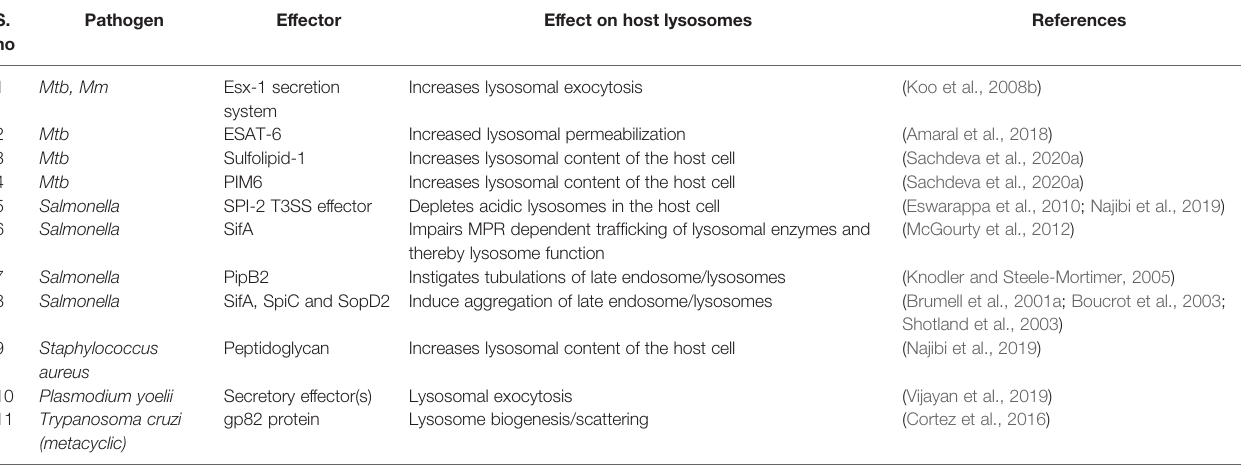
TABLE 1 | Different pathogen and their effectors affecting host lysosomal